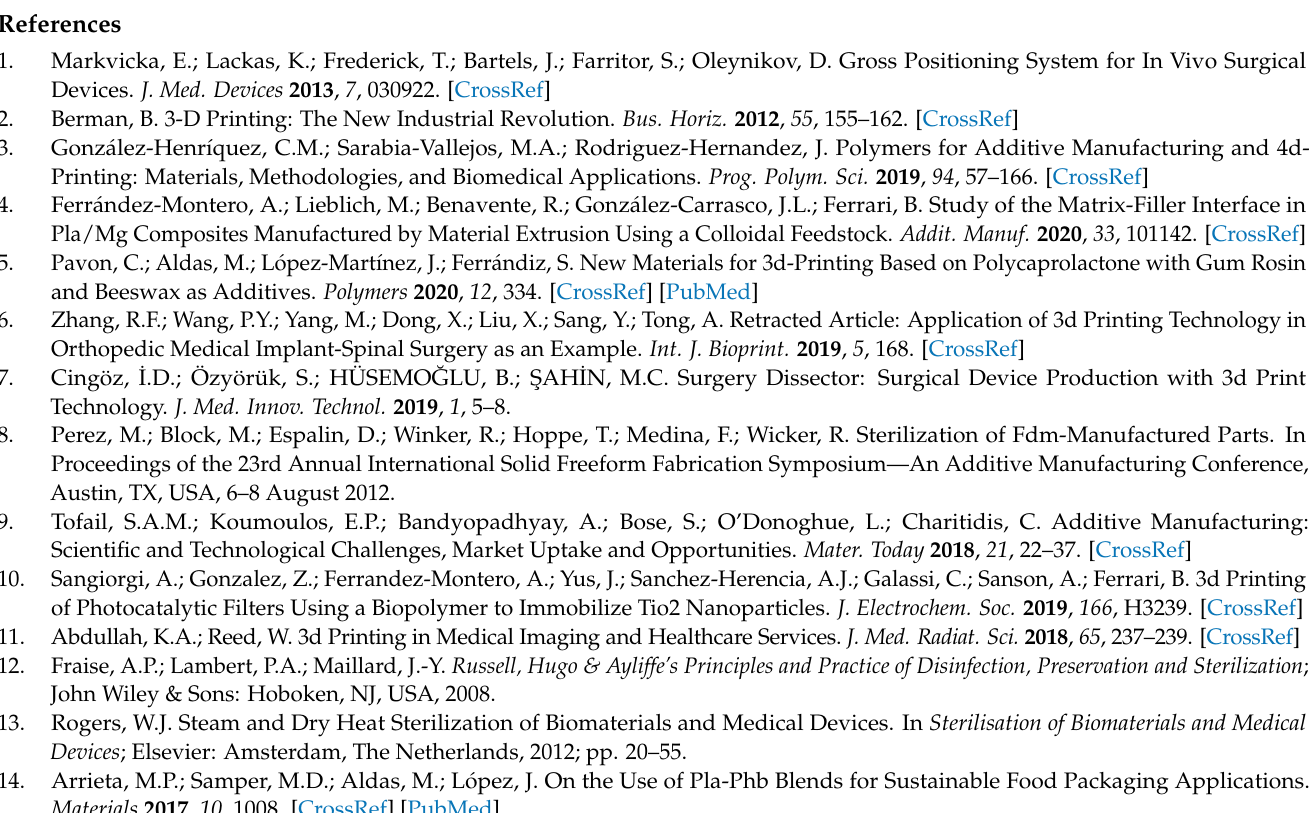
trol dumbbells as well as samples sterilized with DH an MH. Table S1: Main 3D printing parameters of each filament material, obtained from the Slic3r Prusa Edition software; Table S2: DSC and TGA parameters of each printed sample; Table S3: Colorimetric parameters from CIELab space of each 3D-printed sample before and after the sterilization